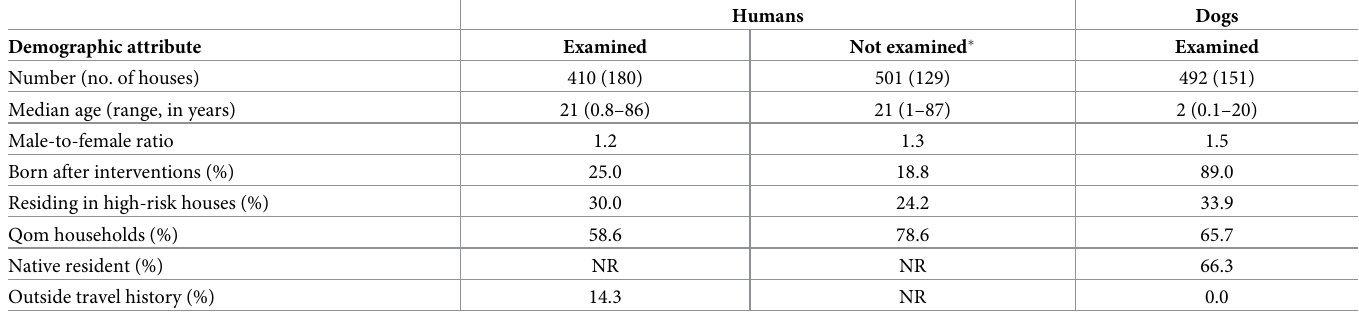
Table 1. Demographic characteristics of human and dog populations, Pampa del Indio, Chaco, 2016–2017.